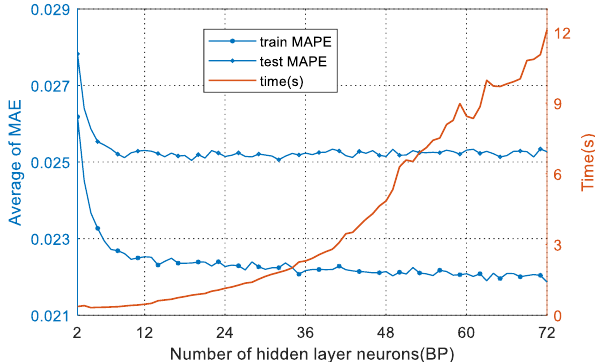
Figure 8. MAPE curves of backpropagation (BP) at different hidden layer nodes.